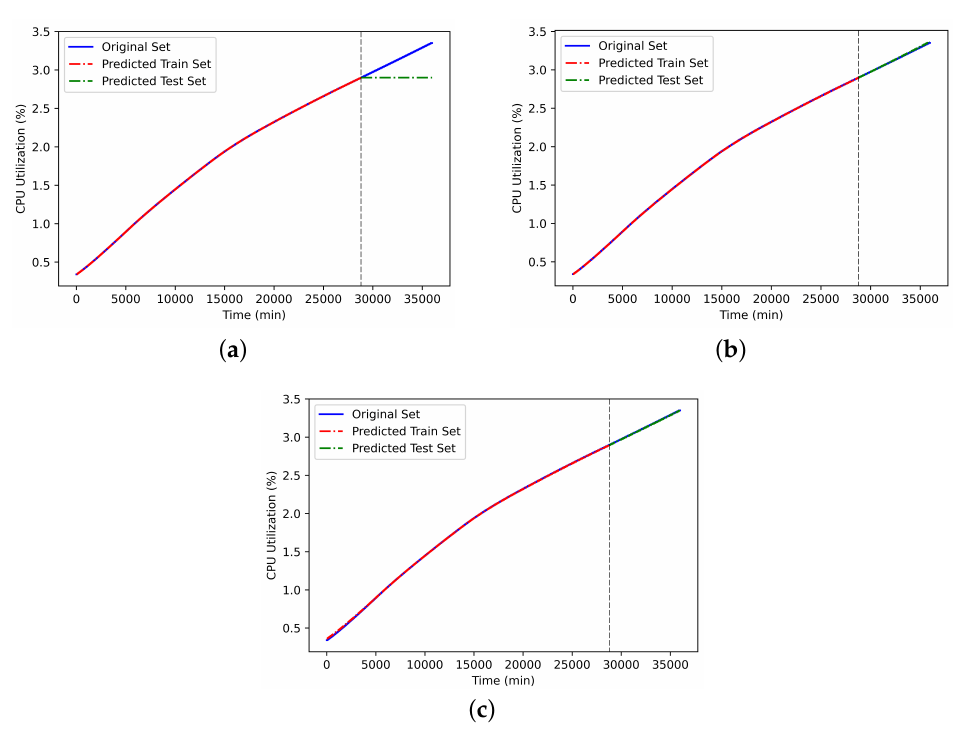
Figure 4. Graphics for data type “CPU utilization”: ( a ) SARIMA; ( b ) Conv-LSTM; ( c ) proposed (moving average + Conv-LSTM).